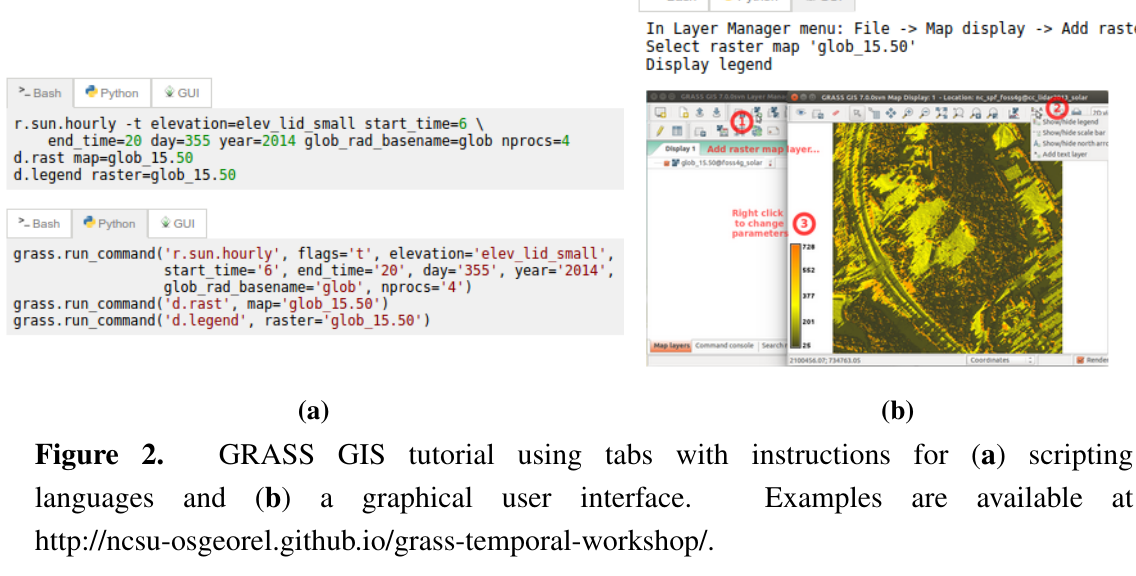
Figure 2. GRASS GIS tutorial using tabs with instructions for ( a ) scripting languages and ( b ) a graphical user interface. Examples are available at